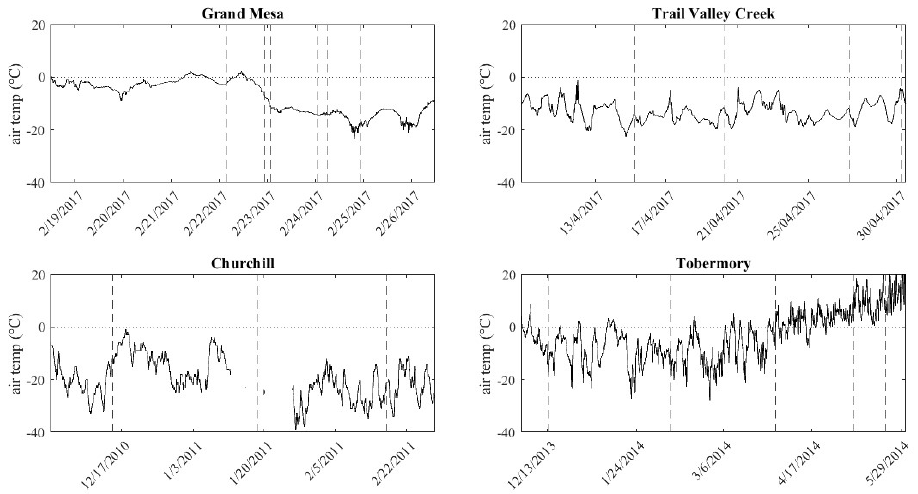
Figure 4. The air temperatures during the observation periods. The vertical lines denote observations.